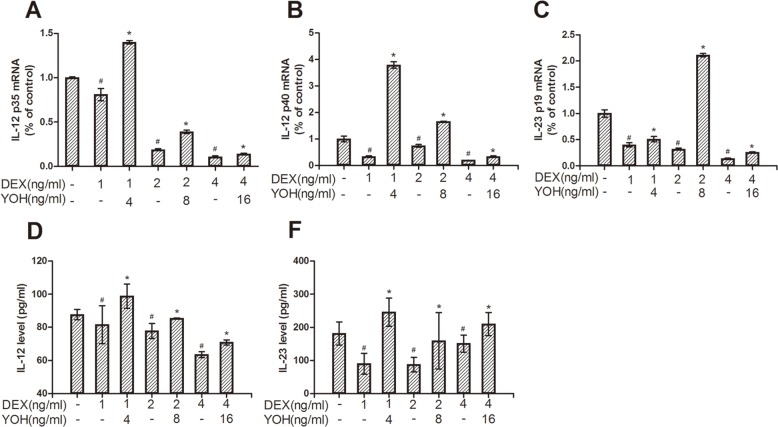
Effect of DEX on IL-12 and IL-23 production in mature DCs.(A), (B) and (C) showed mRNA levels of IL-12 p35, IL-12 p40 and IL-23 p19, respectively. (D) and (E) showed the protein levels of IL-12 and IL-23, respectively. “DEX” is short for dexmedetomidine, “YOH” is short for yohimbine. Immature DCs were differentiated in the absence or presence of different doses of DEX (1ng/ml, 2ng/ml and 4ng/ml) and yohimbine (4ng/ml, 8ng/ml and 16ng/ml) for 1 day before matured with TNF-α (“-”means do not add DEX or yohimbine). Grouping is consistent in these bar charts. The data were expressed as mean±SD of the results from these experiments. #: P<0.05, compared to the control group; *: P<0.05, compared to the relative DEX only group.